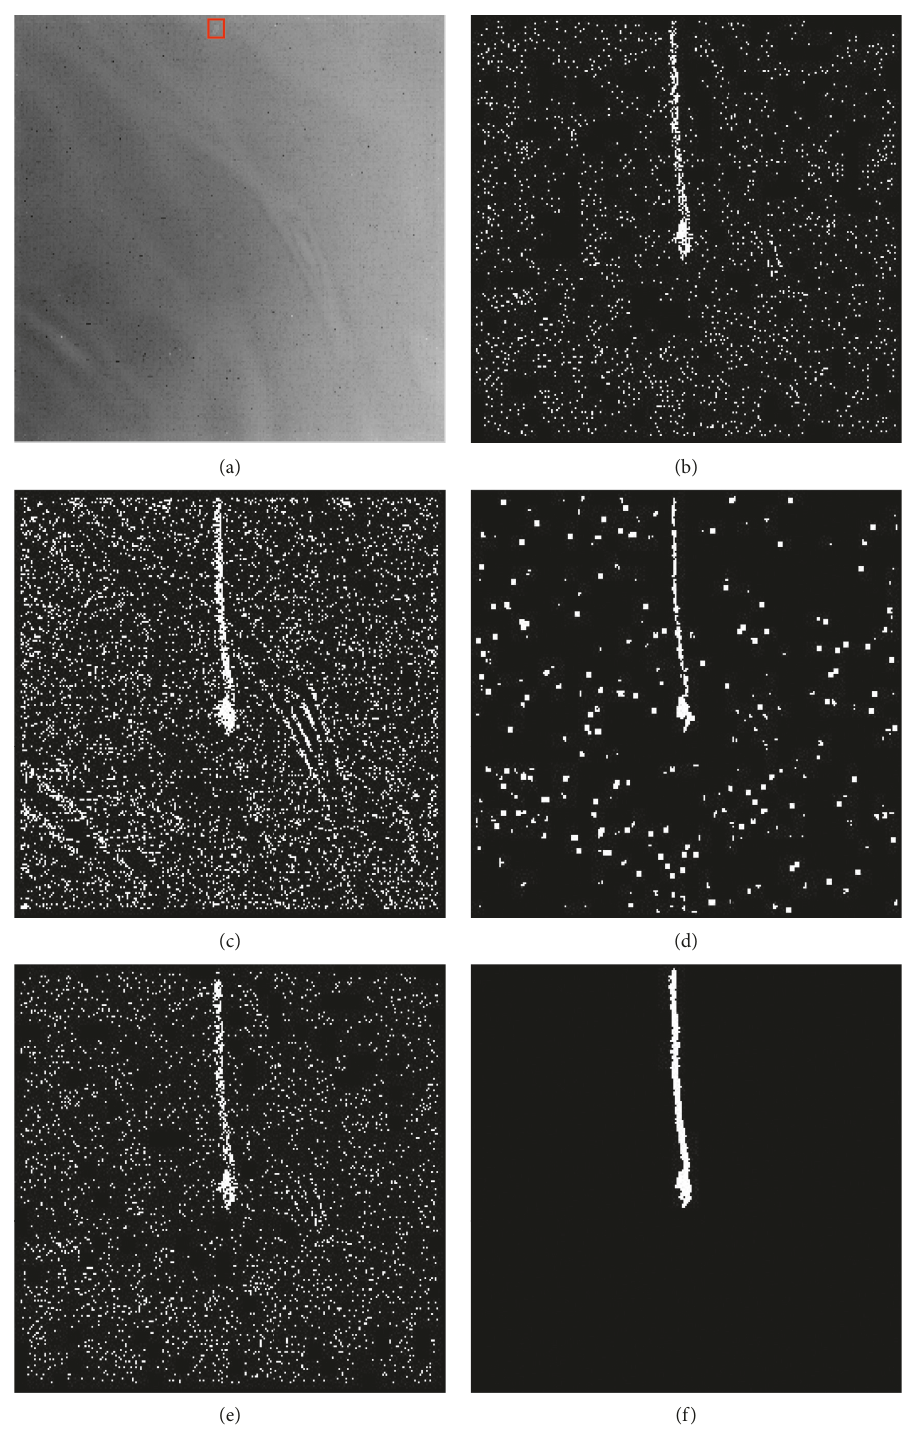
Figure 7: Detection results of different algorithms in scene